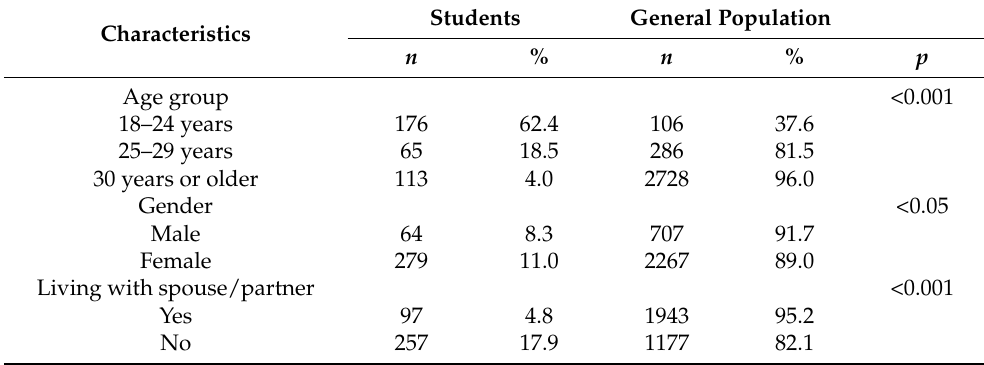
Table 1. Sociodemographic characteristics of students and in the general population. Characteristics